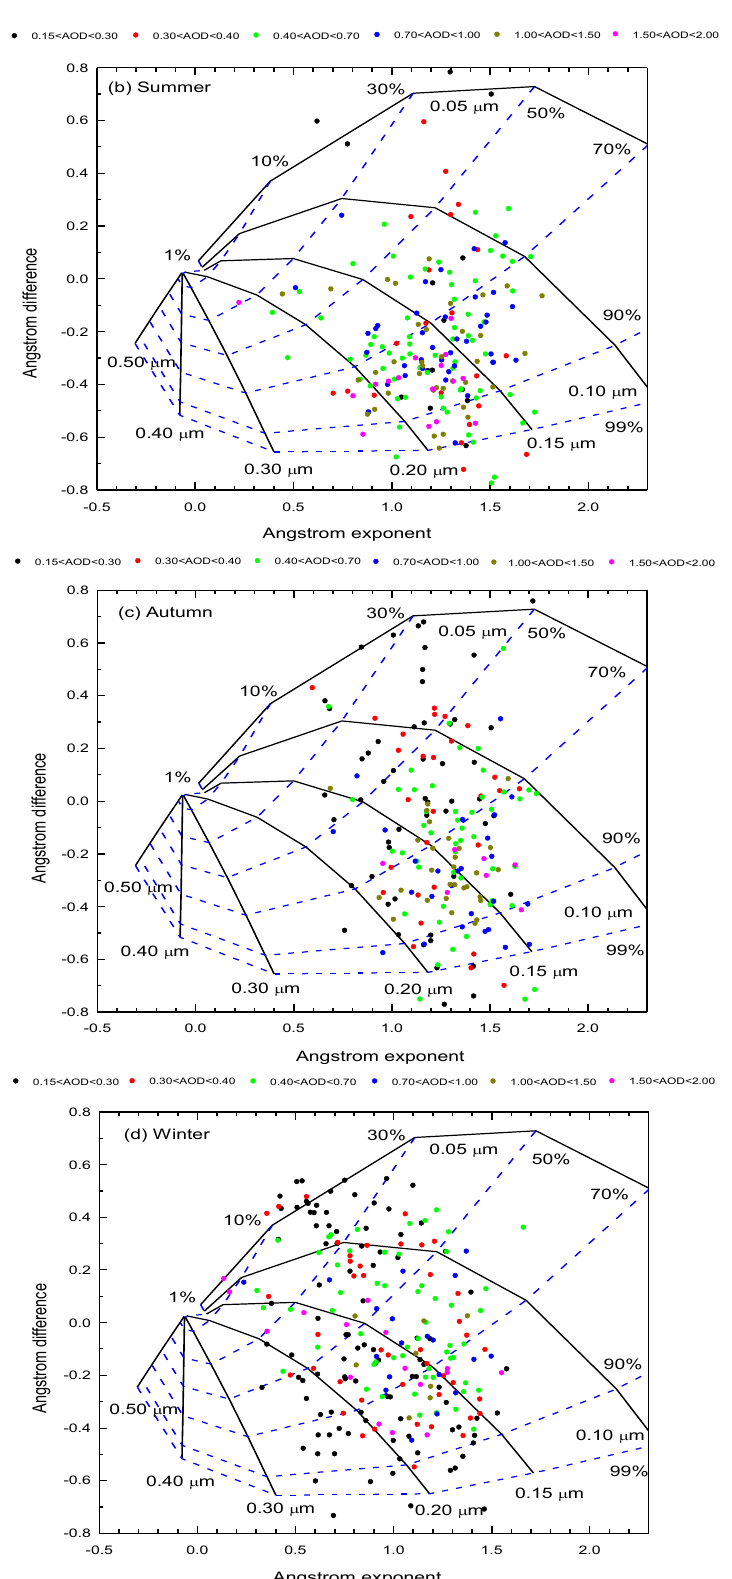
Figure 8. Å ngström exponent difference (δα, α 440–670nm − α 670–870nm ) as a function of the Å ngström Figure 8. Ångström exponent difference ( δα , α 440–670 nm ´ α 670–870 nm ) as a function of the Ångström exponent 440–870nm and AOD 440nm . Only cloud-screened data with AOD > 0.15 were used. ( a ) Spring; ( b ) exponent 440–870 nm and AOD 440 nm . Only cloud-screened data with AOD > 0.15 were used. ( a ) Spring; summer; ( c ) autumn; and ( d ) winter. ( b ) summer; ( c ) autumn; and ( d )